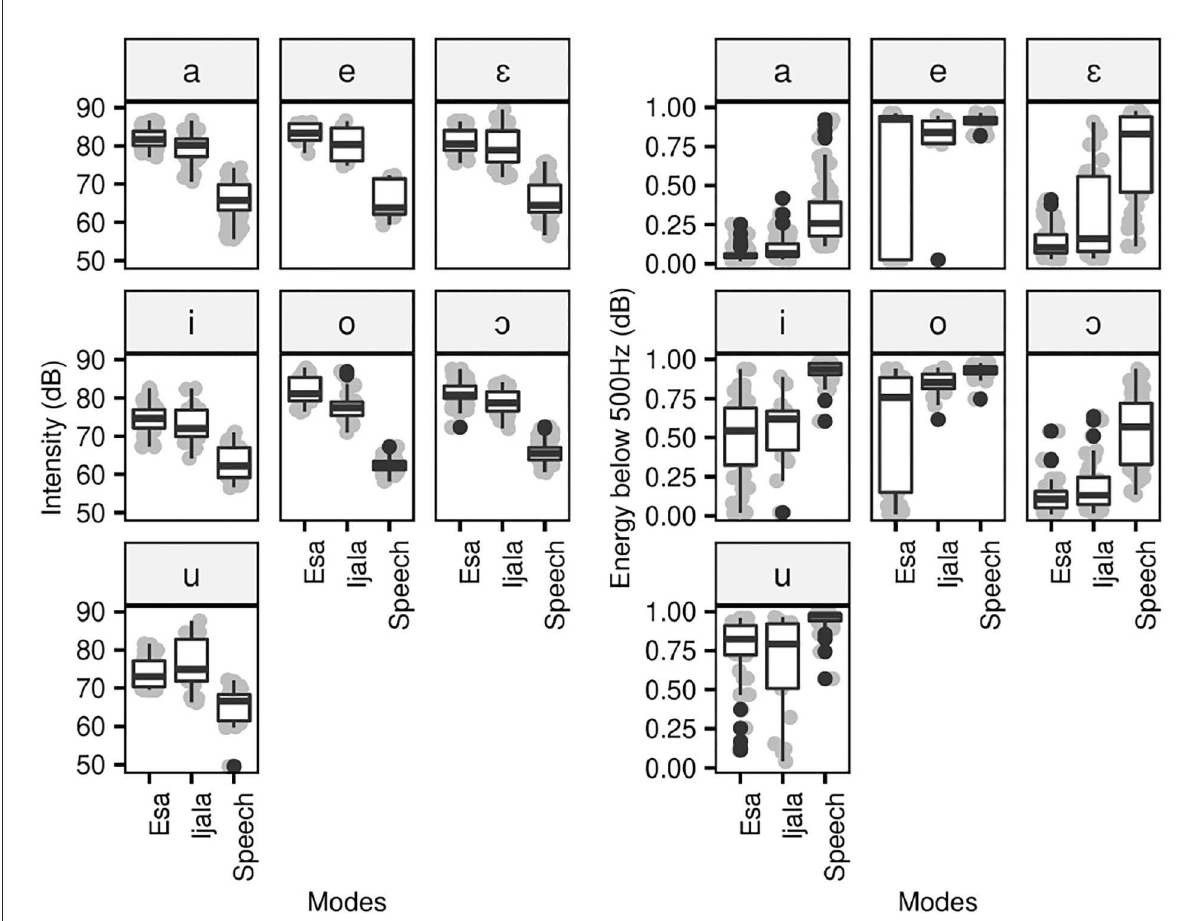
FIGURE6 Intensity and energy below 500(Hz) of oral vowels in poetic and speech